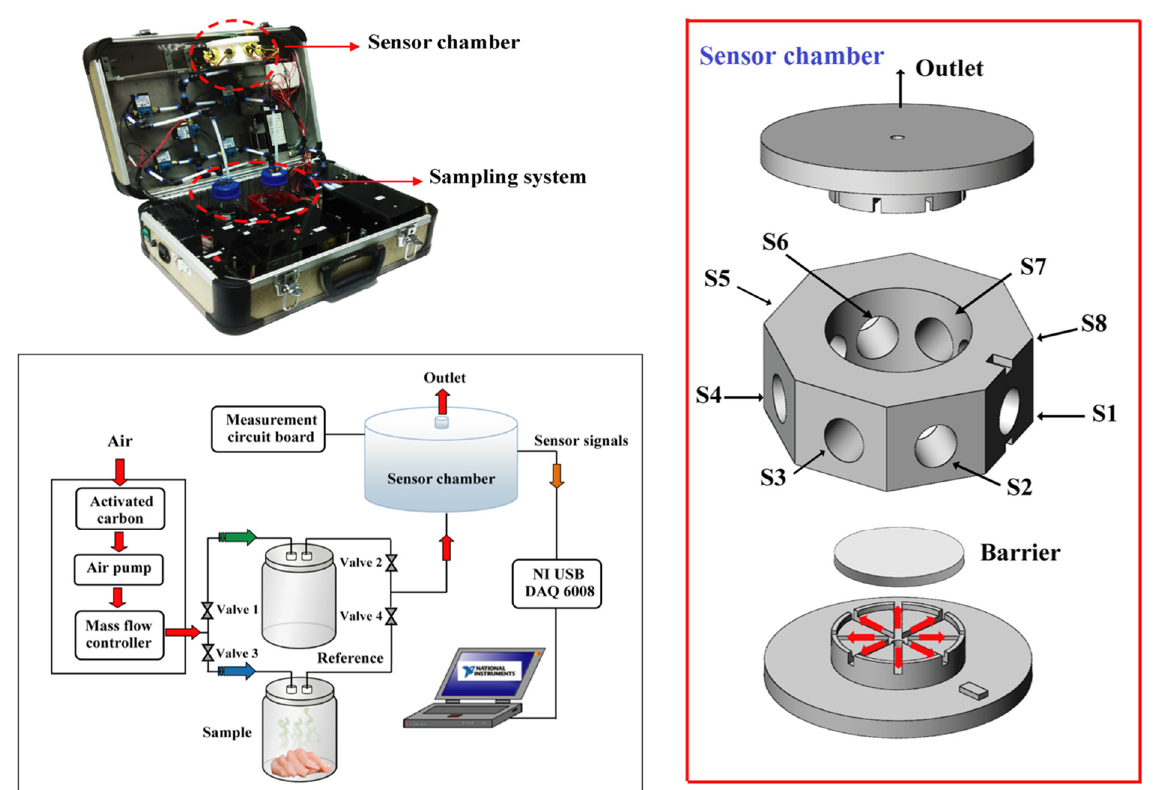
Figure 3. Photograph and schematic diagram of a prototype portable E-nose system. (Reproduced with permission from Elsevier [16].)